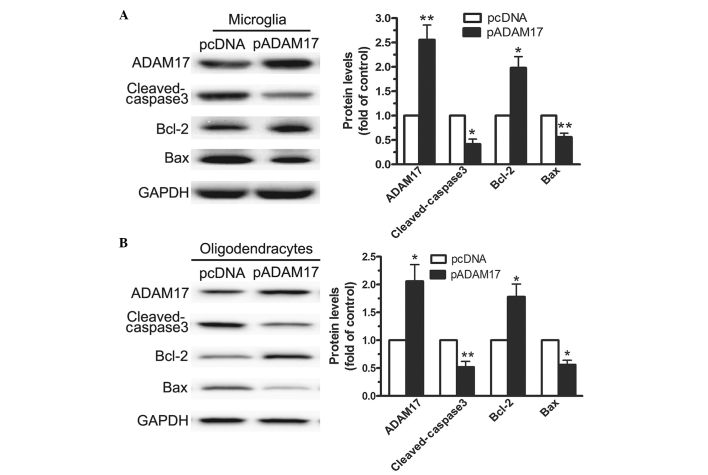
Overexpression of ADAM17 attenuates apoptosis in microglia and oligodendrocyte cells. Western blot analysis was performed to measure the expression levels of ADAM17 and apoptosis effector molecules, cleaved caspase 3, Bcl-2 and Bax, in (A) microglia and (B) oligodendrocytes transfected with pADAM17 or the pcDNA3.1 empty vector control. The data are expressed as the mean ± standard deviation (n=3; *P<0.05 and **P<0.01, vs. control). ADAM17, A disintegrin and metalloprotease 17; Bcl-2, B cell lymphoma; Bax, Bcl-2 associated X protein; p, plasmid.